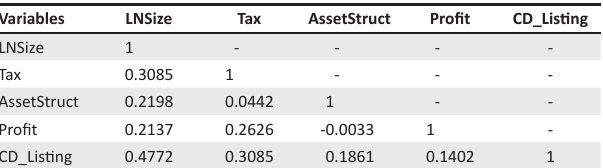
TABLE 6: Covariance matrix.